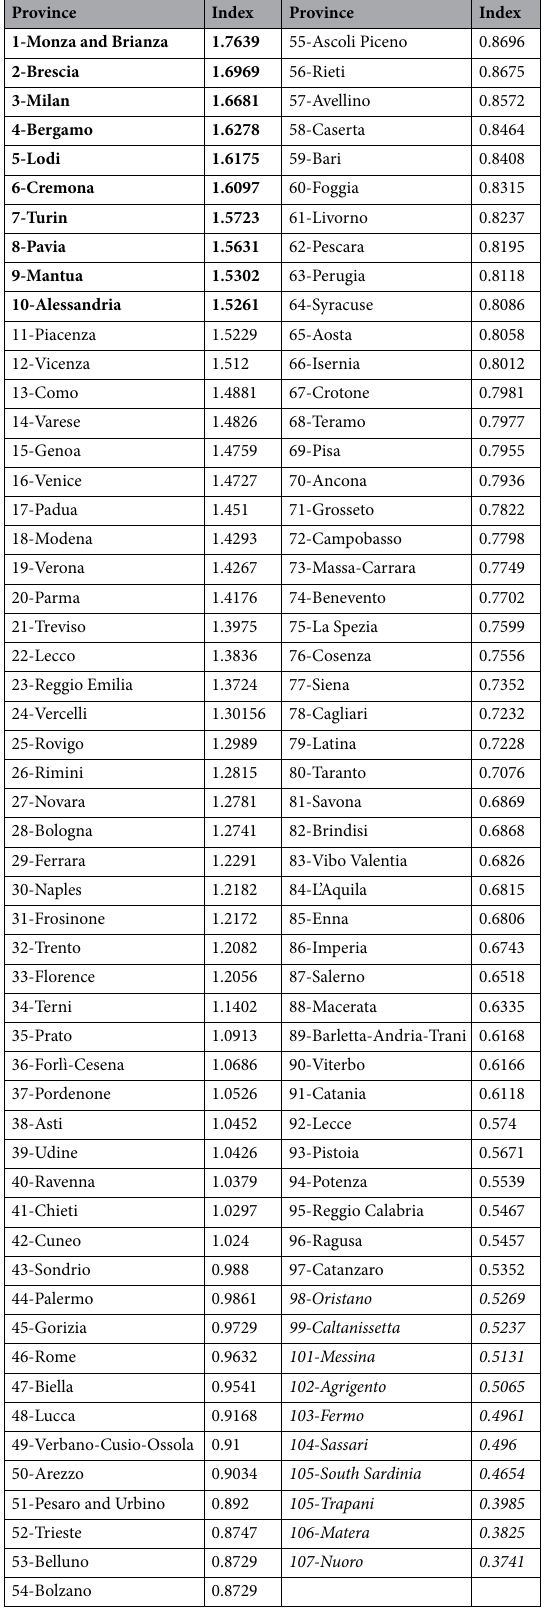
Table 4. A synthetic environmental pollution index for the Italian provinces in the period 2014–2019. The provinces are ranked from the most polluted to the cleanest. The 10 most polluted provinces are bold, while the 10 cleanest provinces are